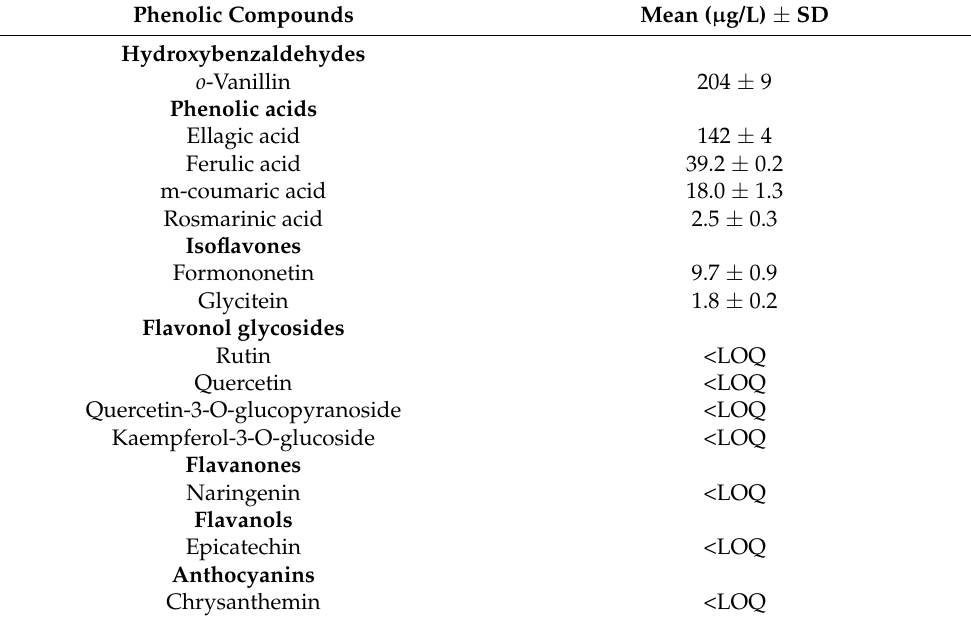
Table 4. Phytochemical content in the avocado honey